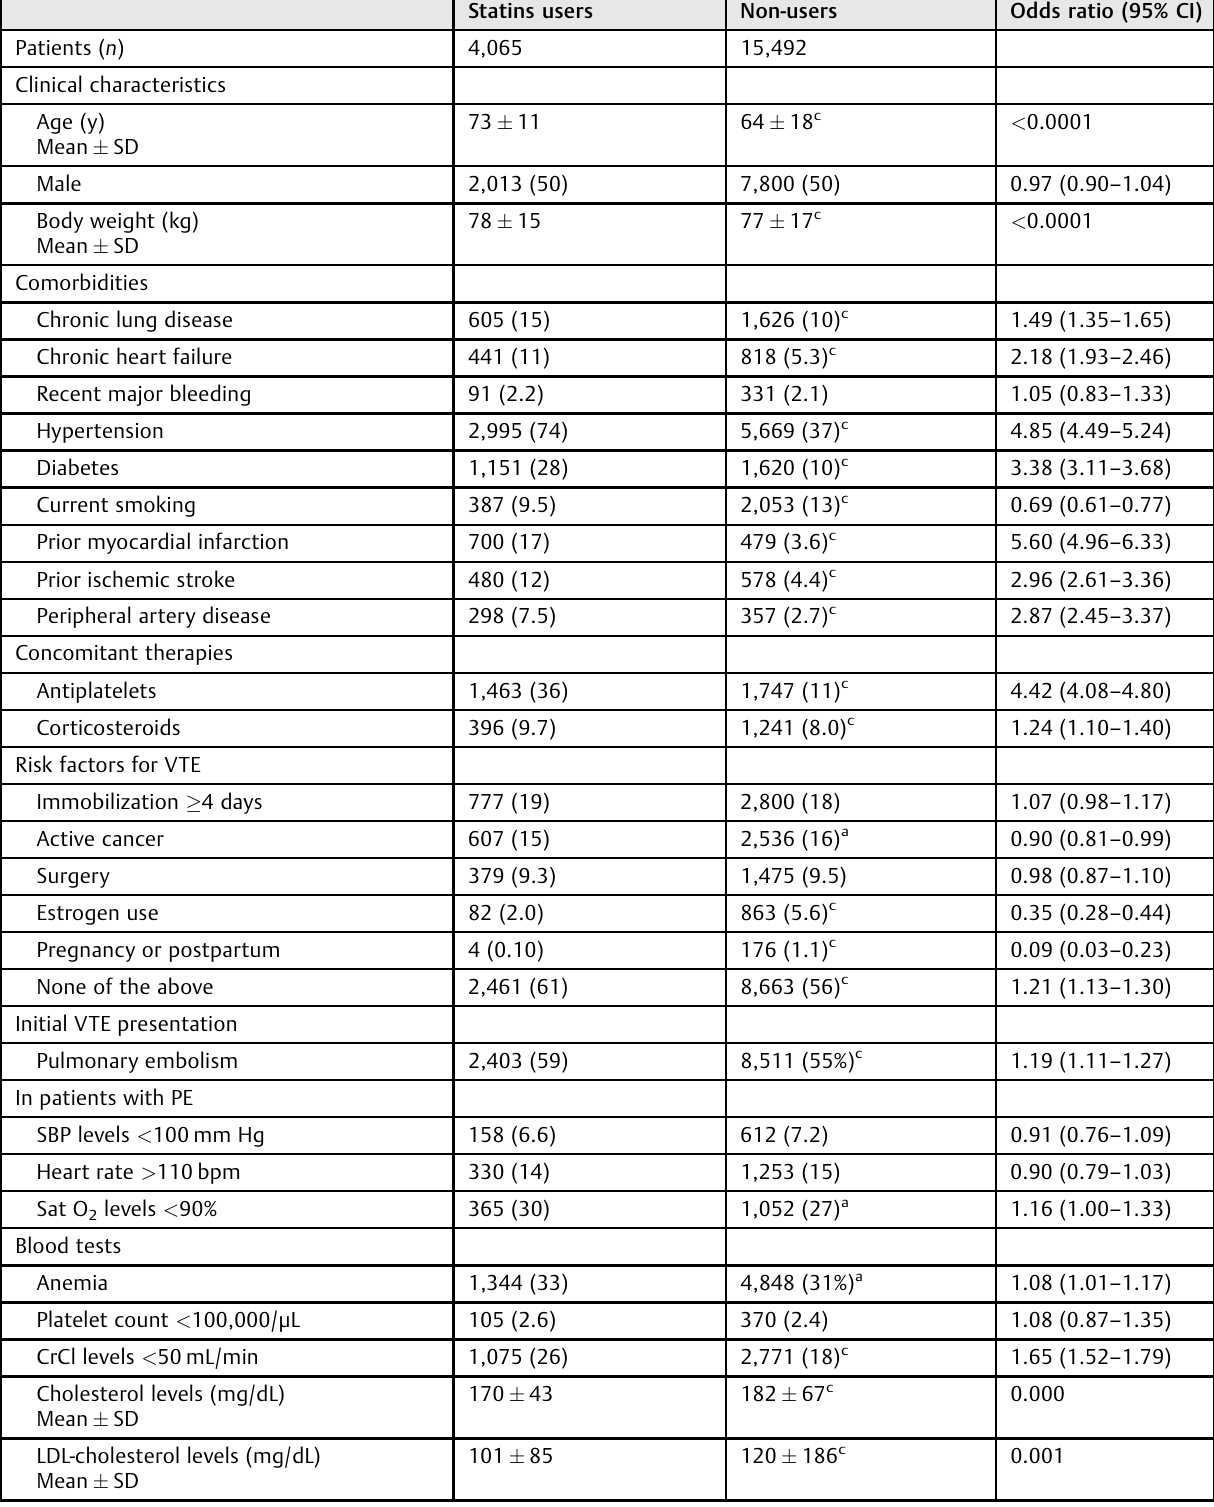
Table 1 Clinical characteristics in 19,557 patients with VTE, according to use of statins at